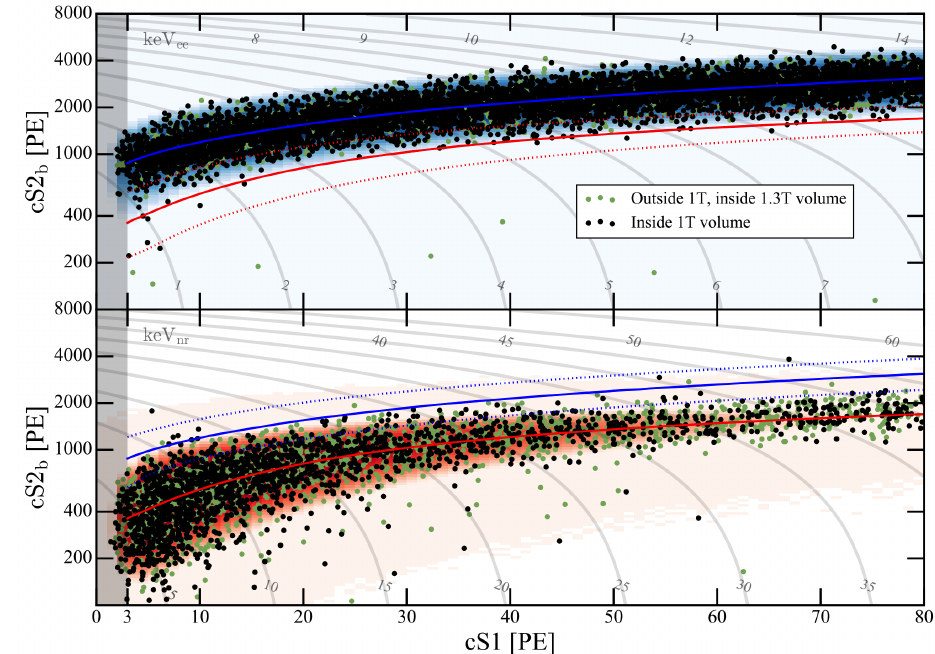
Figure 3. Separation between ER (top panel) and NR (bottom) populations as observed in the XENON1T TPC. ER data points are collected with a 220 Rn calibration source, while NR events are produced by a Deuterium–Deuterium fusion neutron generator. Data points are shown within an inner 1 t core volume (black) and outside within a 1.3 t volume (green). The models extracted from the calibration data for ER (blue) and a 200 GeV/c 2 WIMP (red) are shaded and additionally drawn as 10%–50%–90% (dotted-solid-dotted) contour lines. The energy axes for ER (top) and NR (bottom) are drawn as grey contours. The ER discrimination power is usually evaluated in the ( cS 2/ cS 1 vs. cS 1) space. The ratio between S 2 and S 1 is typically referred to as the discrimination parameter. Image from Ref.